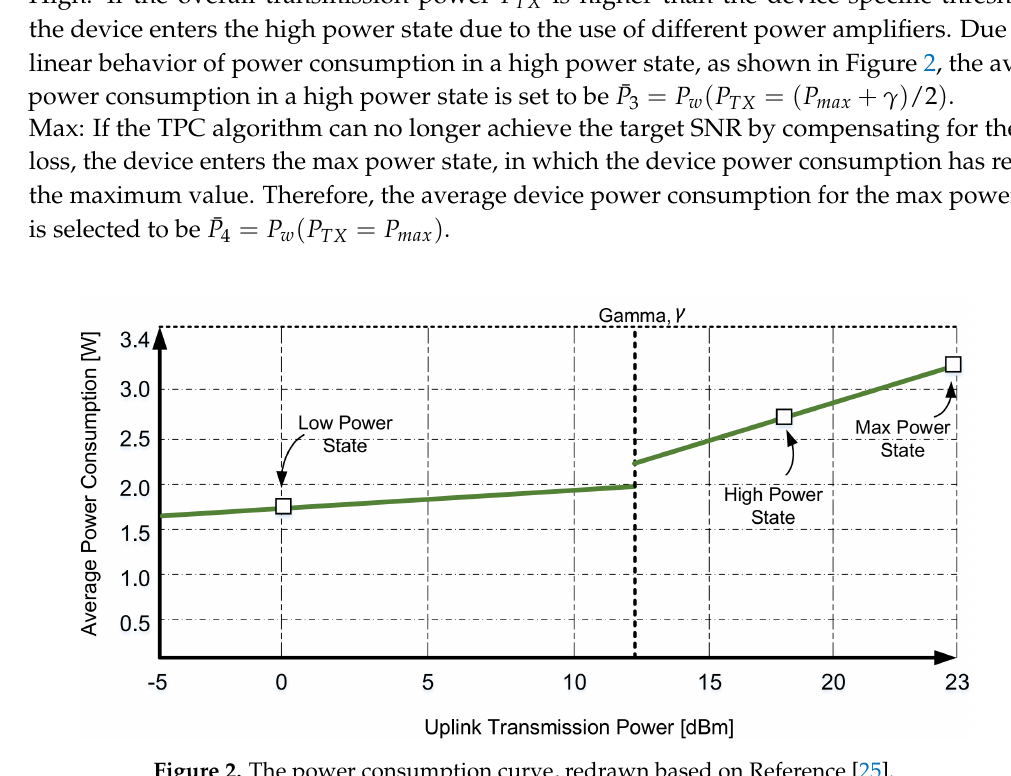
Figure 2. The power consumption curve, redrawn based on Reference